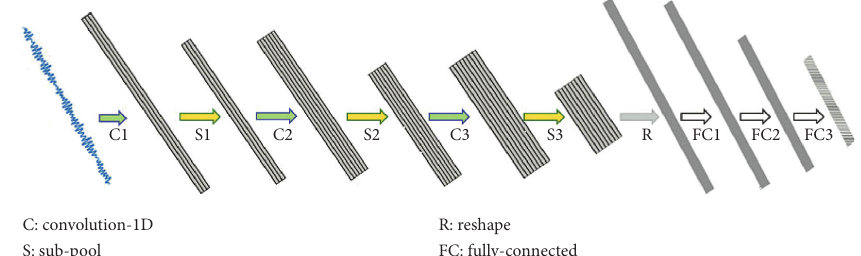
Figure 5: A 1-D CNN model for hybrid fault